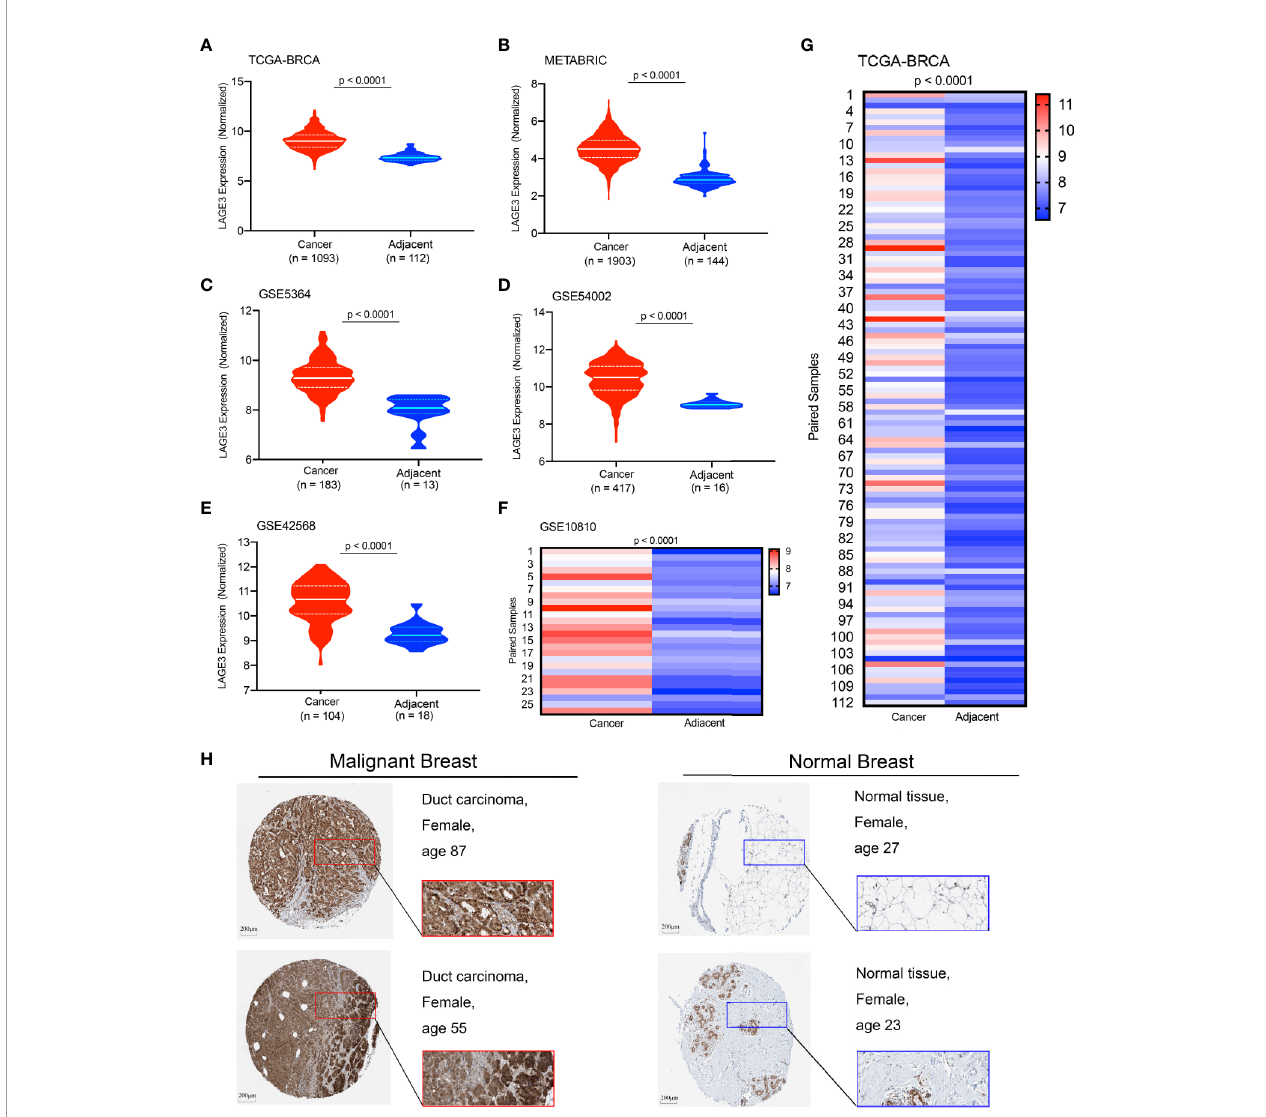
FIGURE 1 | Expression pro fi le of LAGE3 in malignant and normal breast tissues. The LAGE3 transcript levels in BC and adjacent normal breast tissues from the (A) TCGA-BRCA cohort; (B) METABRIC dataset; (C) GSE5364; (D) GSE54002; and (E) GSE42568 are presented as violin plots. (F, G) The heatmap was showing LAGE3 mRNA expression in matched BC and corresponding adjacent normal breast tissues in GSE10810 and TCGA cohorts. (H) Representative immunohistochemistry images and detailed information of LAGE3 in malignant and normal breast tissues were obtained from The Human Protein Atlas